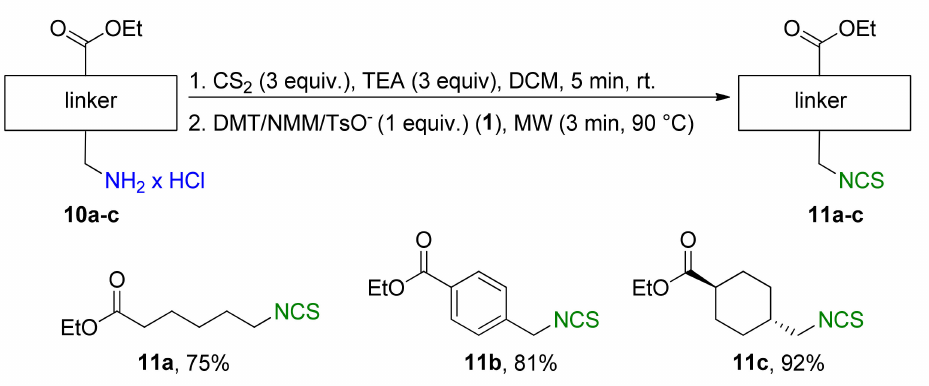
Figure 6. Synthetized isothiocyanates 11a – c derived from unnatural amino acids a . a -conditions: hydrochloride 10a – c (2 mmol), Et 3 N (0.83 mL, 3 equiv., 6 mmol), CS 2 (0.36 mL, 3 equiv., 6 mmol), DCM (5 mL); first step 5 min, rt, then DMT/NMM/TsO − ( 1 ) (0.828 g, 1 equiv., 2 mmol,), MW irradiation in standard mode 3 min, 90 ◦ C. Yield of products after flash chromatography (hexane:EtOAc